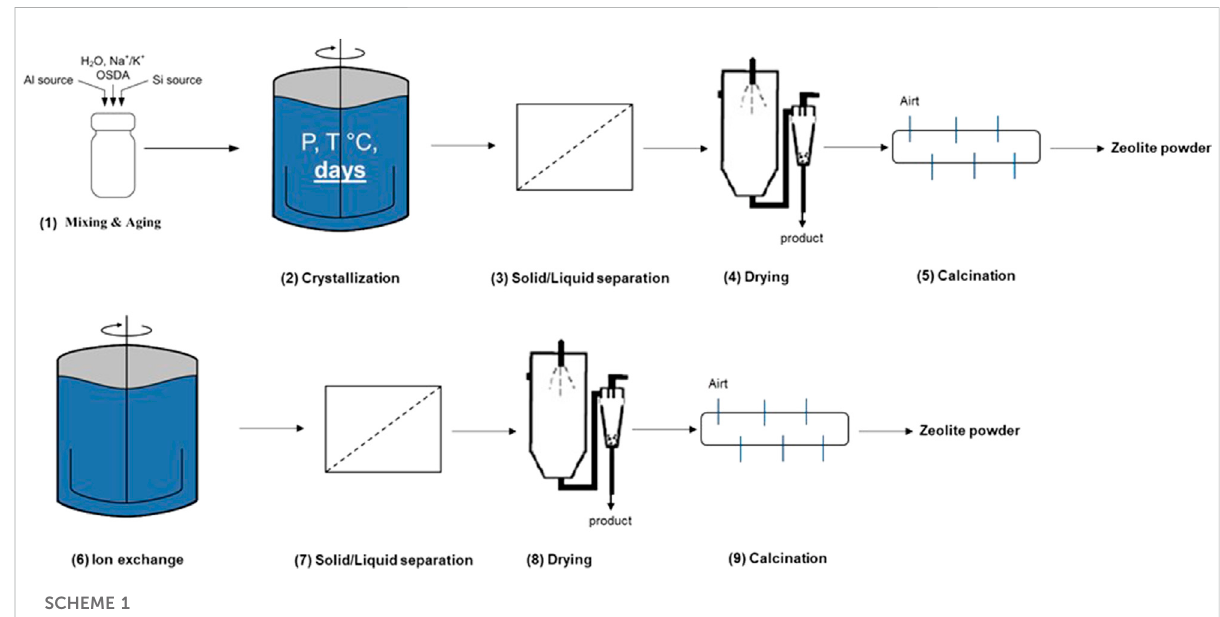
SCHEME 1 General zeolite manufacturing